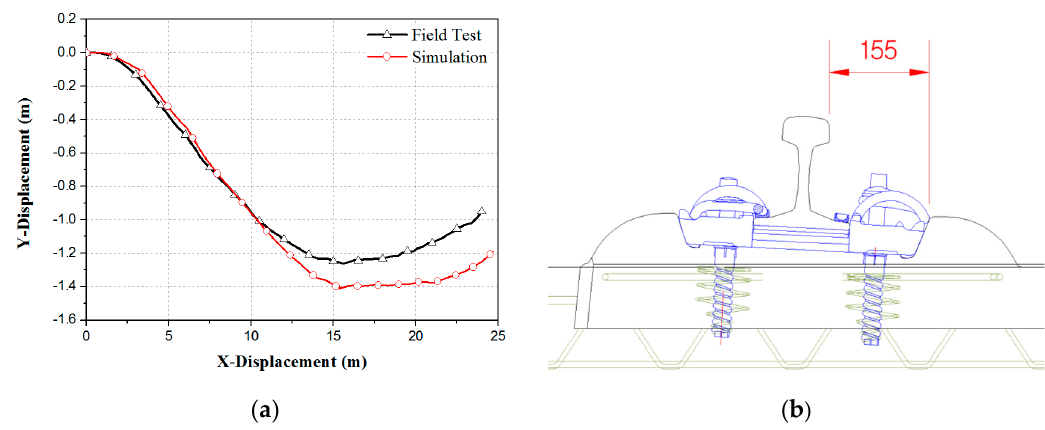
Figure 13. The comparison of results between the field test and the simulation. ( a ) Y-Displacement (Lateral); ( b ) The drawing of a concrete sleeper.